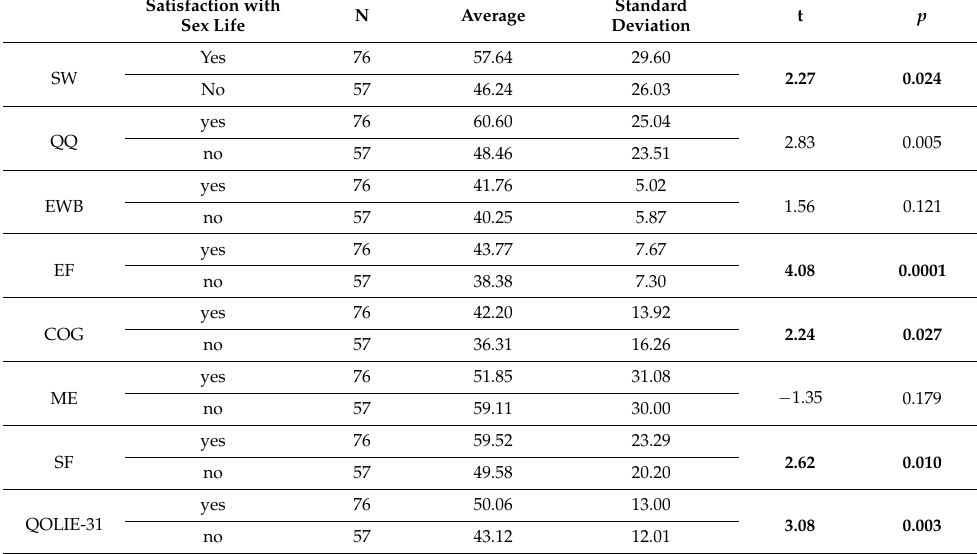
Table 4. QOLIE-31 results in the groups reporting satisfaction and dissatisfaction with sex life, a comparative analysis (statistically significant correlations p ≤ 0.001 in bold).